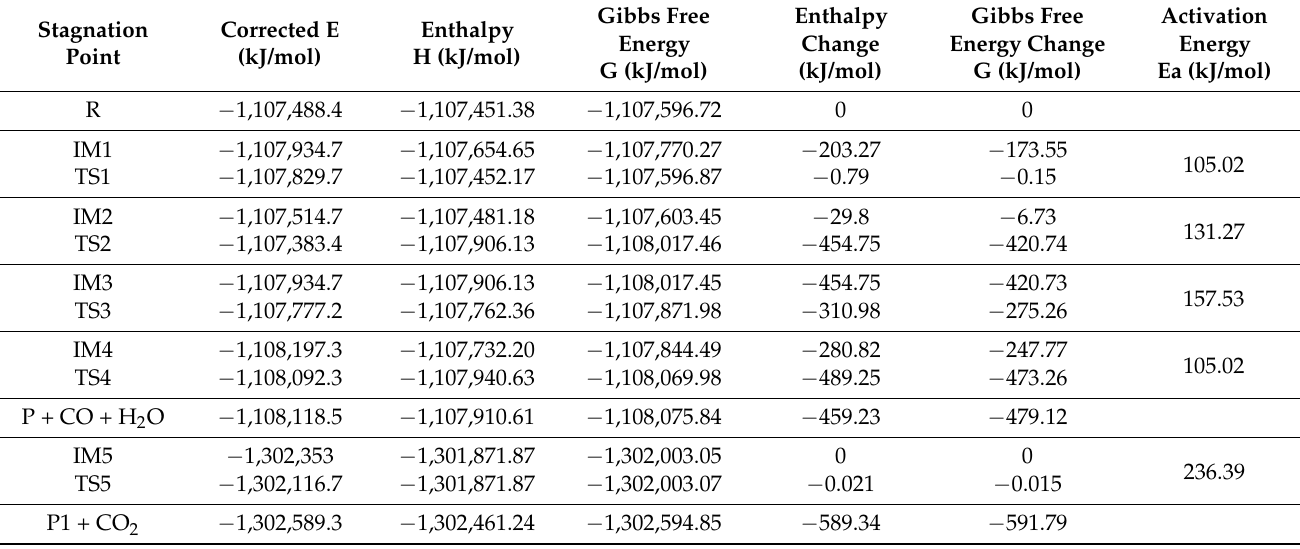
Table 2. Thermodynamic parameters of ph-CH 3 with O 2